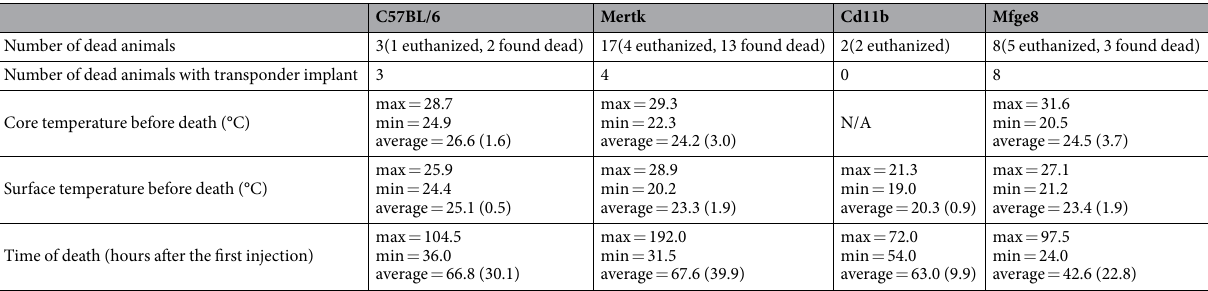
Table 1. Number of dead and transponder-implanted animals, time of death and last recorded core and surface temperatures before death following lipopolysaccharide (LPS) injection per genotype. No transponder- implanted Cd11b animals died, thus their near-death core temperature was not assessed. N/A: not